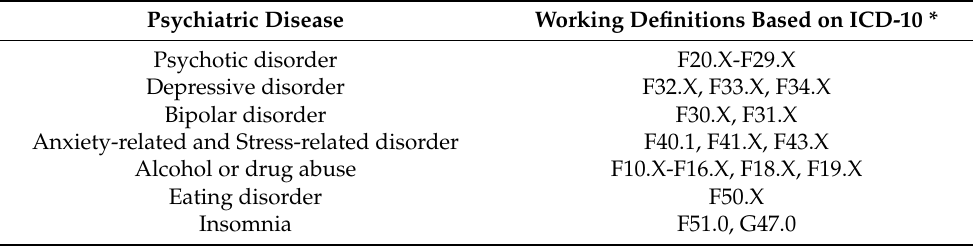
Table 1. Working definitions derived from the insurance